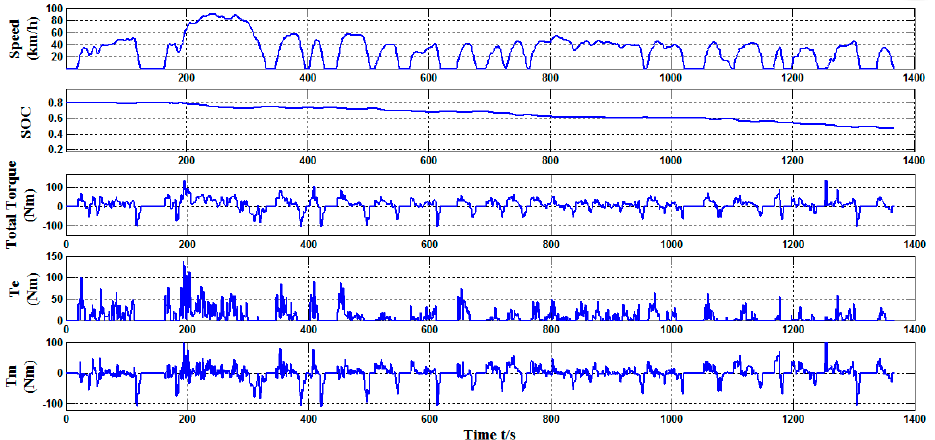
Figure 7. Simulation results of the trained EMS under UDDS. Table 3. Comparison of the results under UDDS.